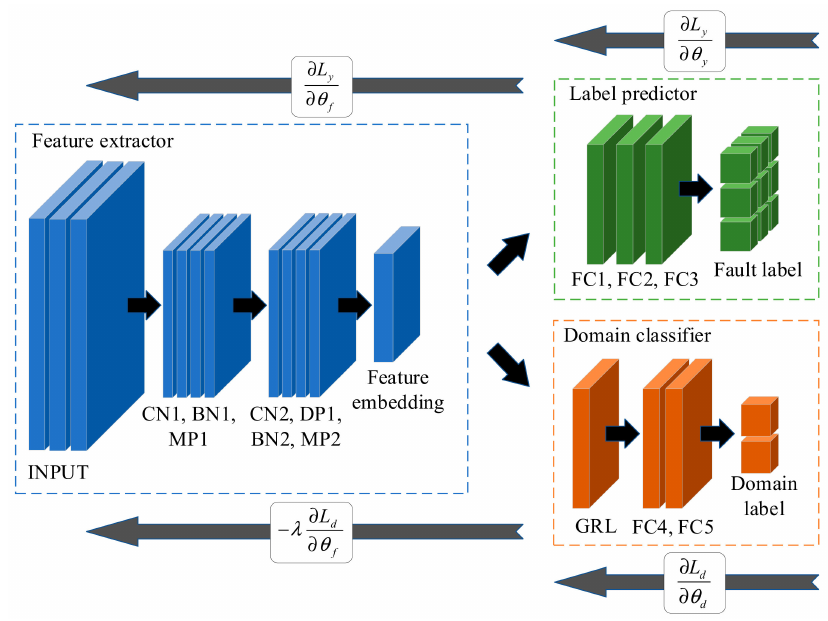
Figure 1. The structure of DANN.